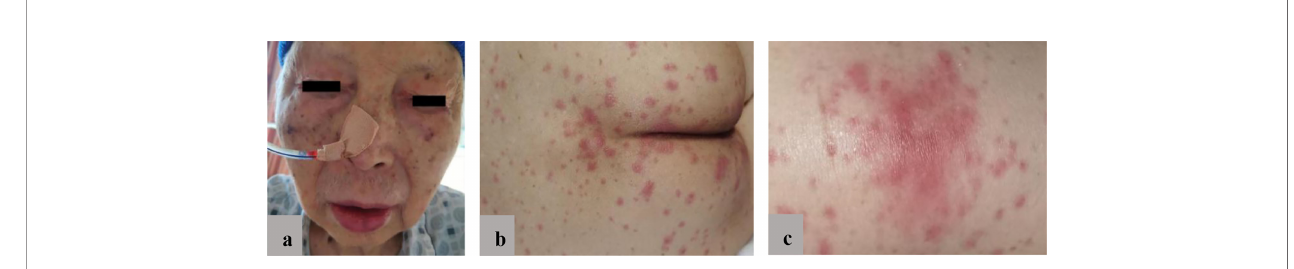
FIGURE 2 | (A) Redness and swelling around the eyes; (B) Diffuse erythematous plaques involving perianal area; (C) Close-up view of the topical